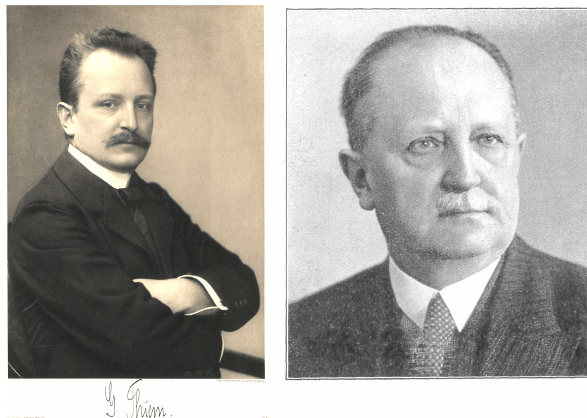
Figure 7. Photos of Günther Thiem from around 1910 (left; Anony- mous, 1910) and around 1940 (right; Thiem,